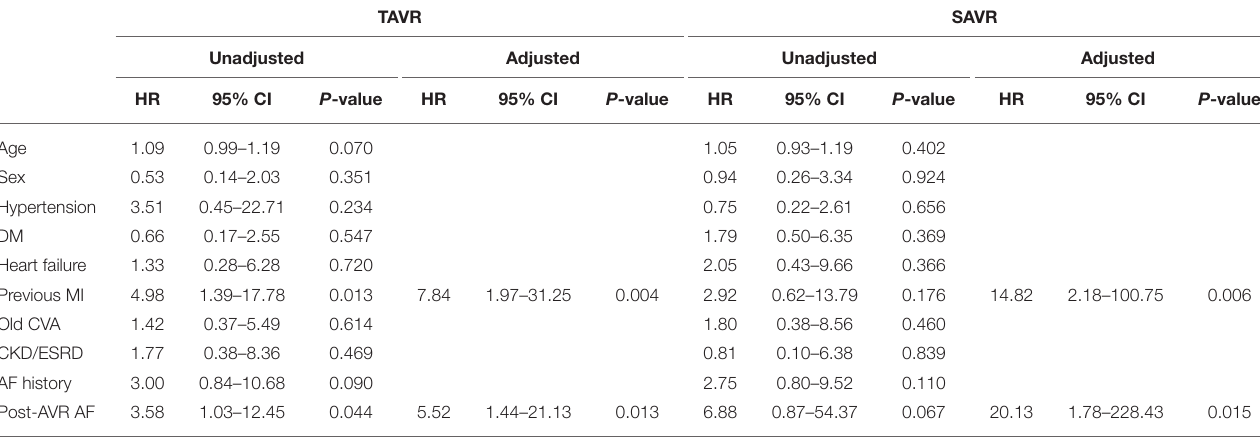
TABLE 4 | Risk factors of worse composite outcome in patients with TAVR and SAVR after PS-matching. TAVR SAVR Unadjusted Adjusted Unadjusted Adjusted HR 95% CI P -value HR 95% CI P -value HR 95% CI P -value HR 95% CI P